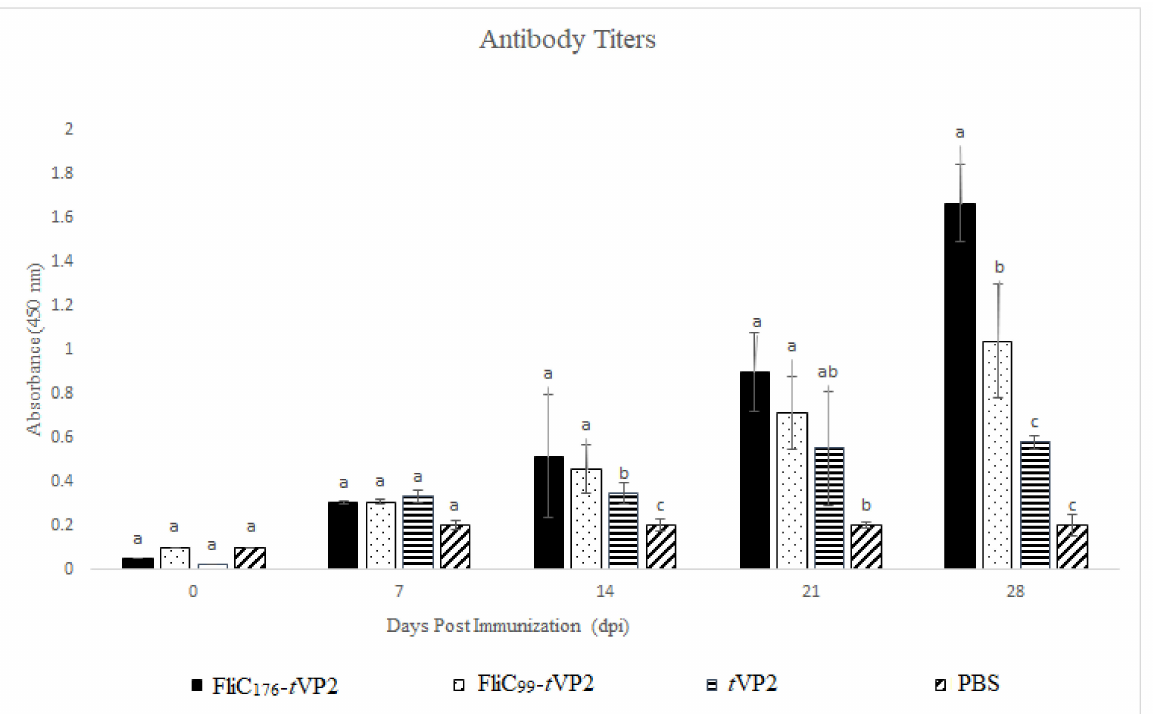
Indirect ELISA was used to determine the levels of antibody response, with t VP2 as the coating antigen. On Day 21 and 28, the levels of the antibodies went up in the FliC 176 - t VP2 and FliC 99 - t VP2 groups as compared to the t VP2-only group (Figure 4), indicating that the flagellin enhanced antibody production.